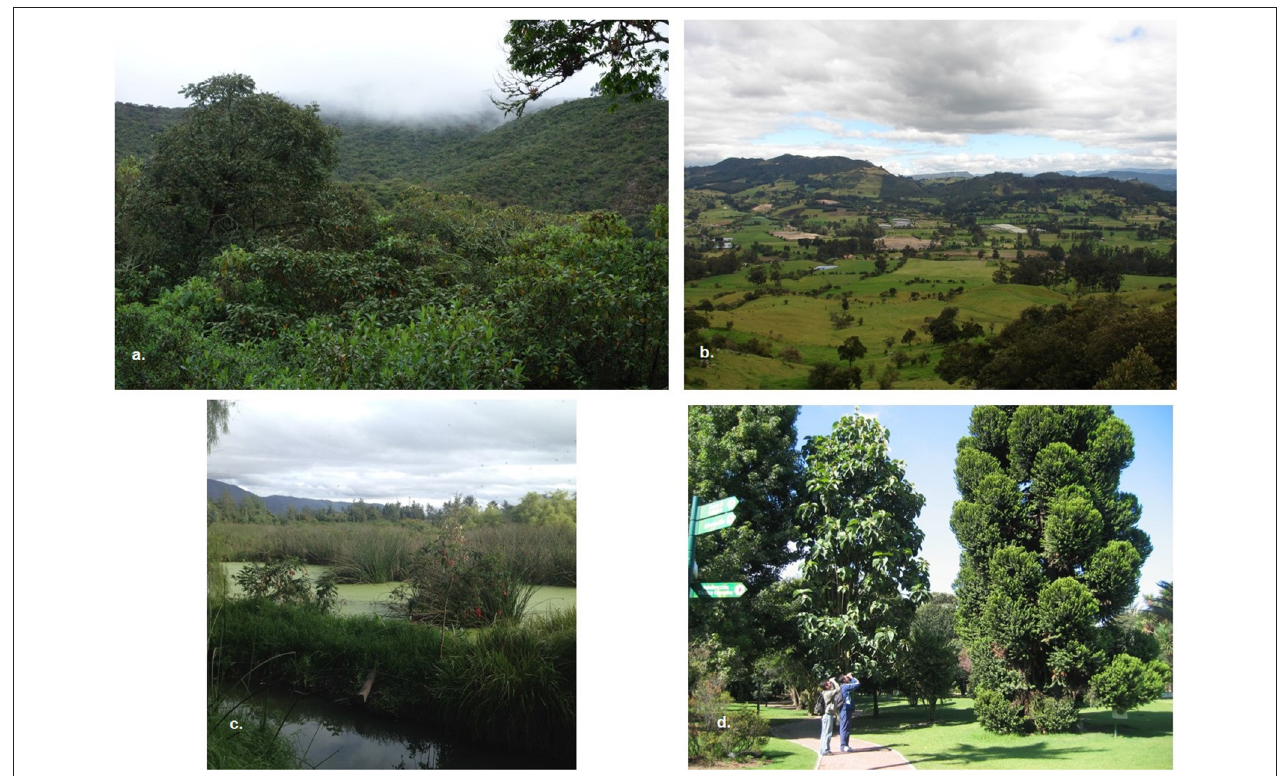
FIGURE 2 | Main habitats of Audubon’s Christmas Bird Counts in the Sabana de Bogotá from 1989 to 2015. (a) Native forests and secondary scrub (NFS). (b) Open rural areas (ORA). (c) Wetlands (WET). (d) Urban forested parks